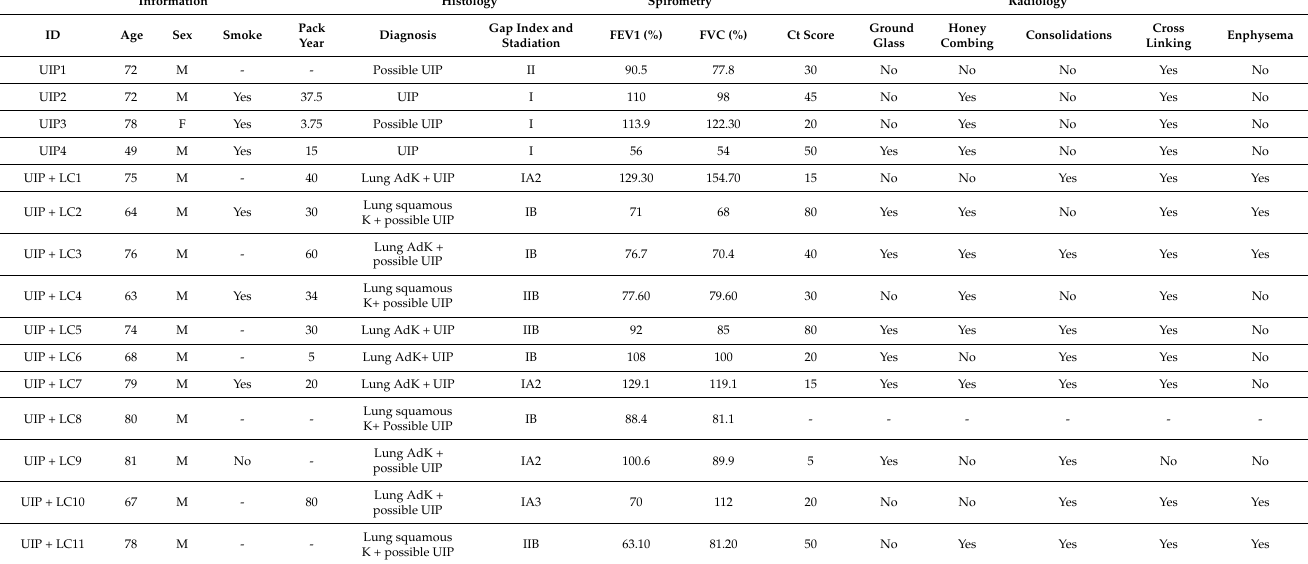
Table 2. Characteristics of UIP/IPF and UIP/IPF cancer -associated patients recruited for the study. Information Histology Spirometry Radiology